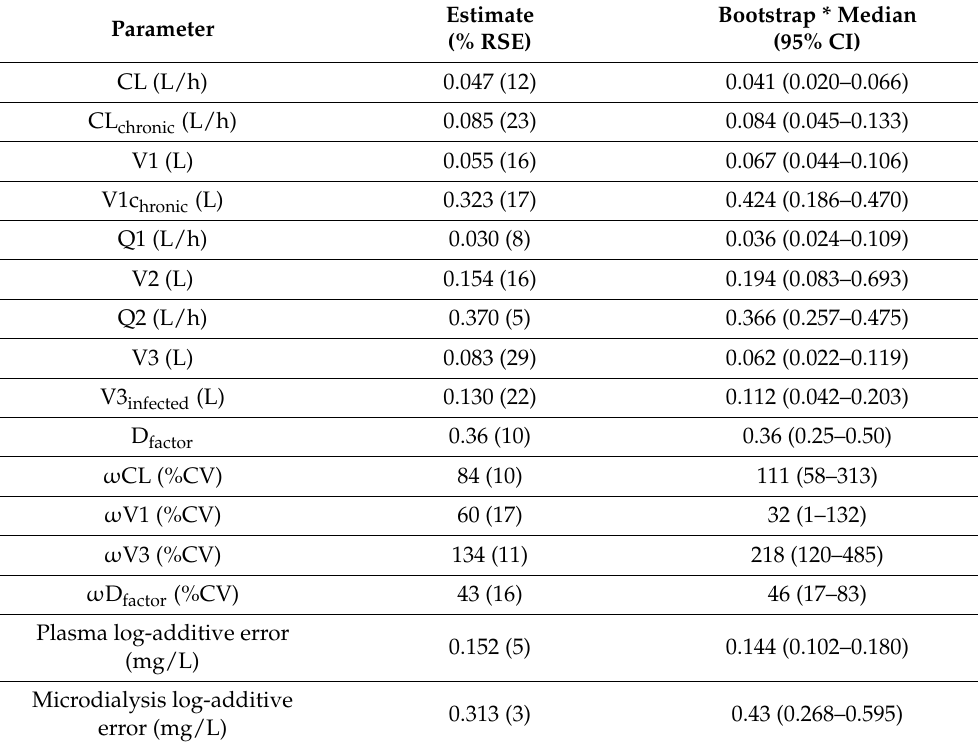
Table 1. Population pharmacokinetic parameters estimate for the popPK